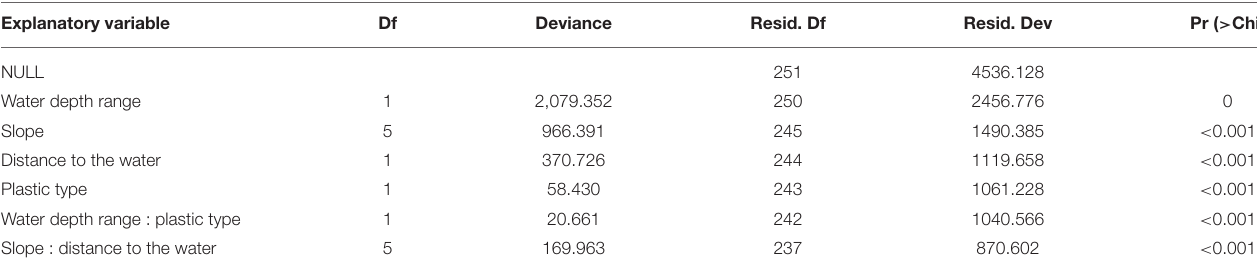
TABLE 2 | Generalized linear model output with explanatory variables, degrees of freedom (Df), deviance, residual degrees of freedom (Resid. Df), residual deviance (Resid. Dev), and the p -values based on a Chi squared test[Pr( >